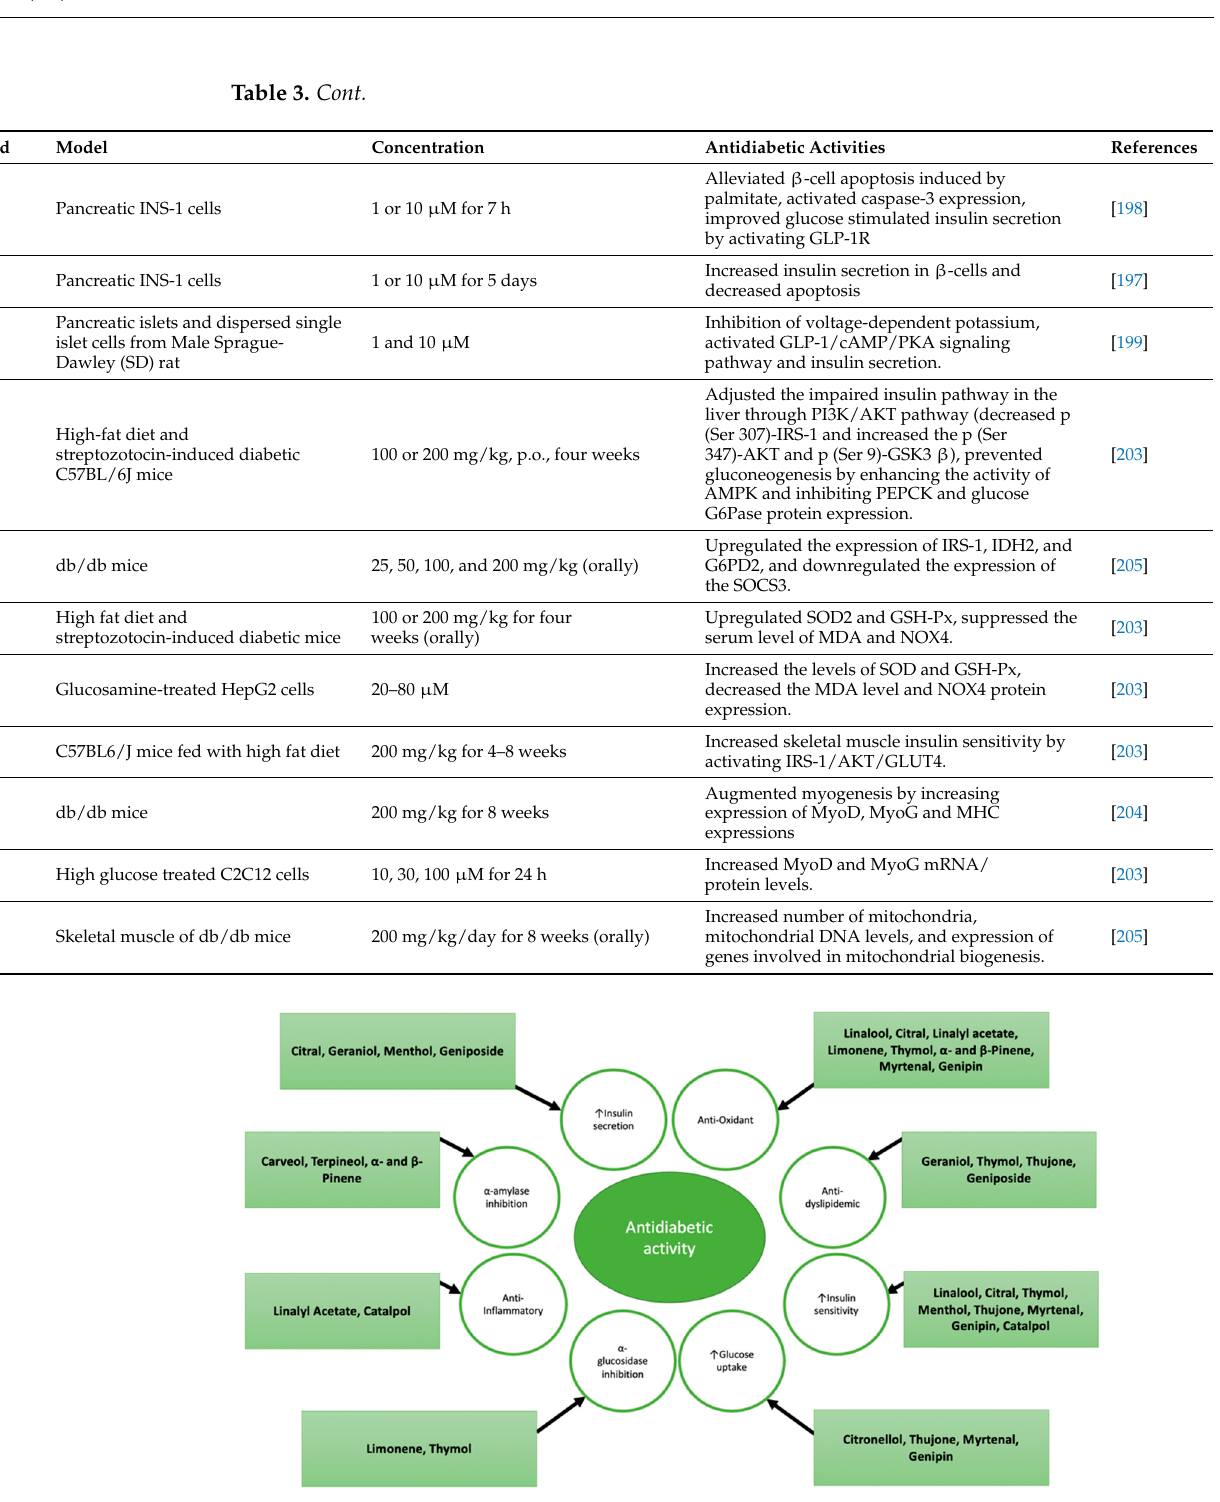
Figure 4. Mechanisms of action of different